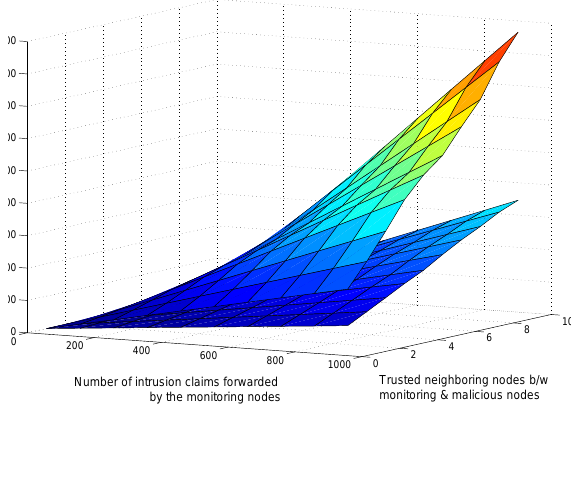
Figure 6. Effect of false alarm tolerance factor on